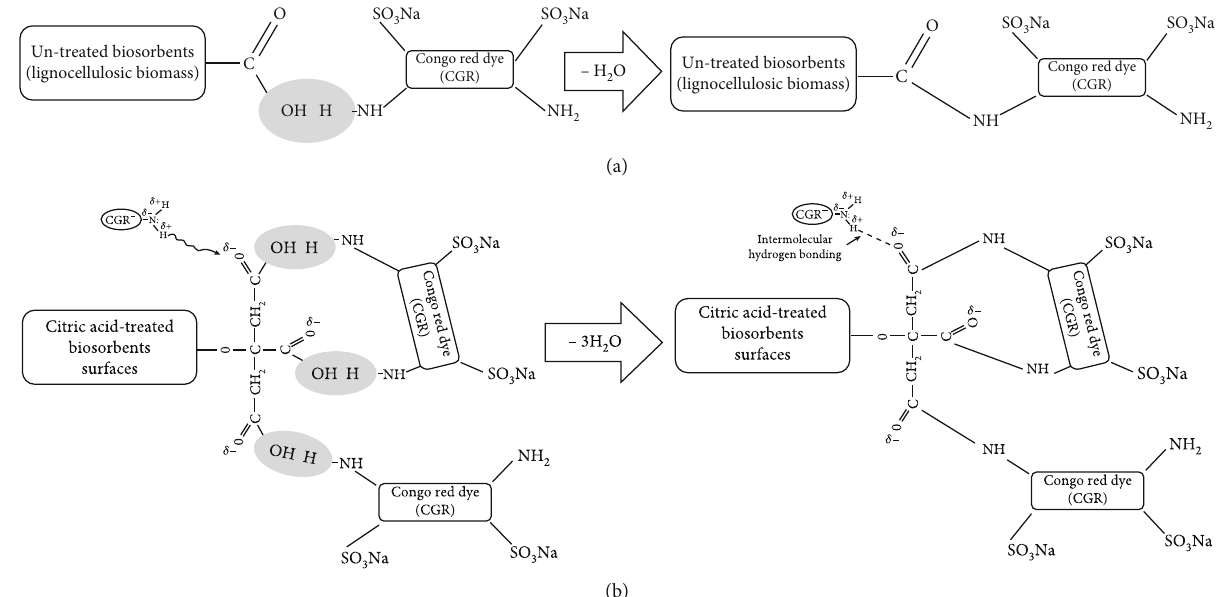
Figure 20: Schematic mechanism of adsorption for CGR ((a) adsorption on untreated adsorbents and (b) adsorption on citric acid-treated adsorbents).